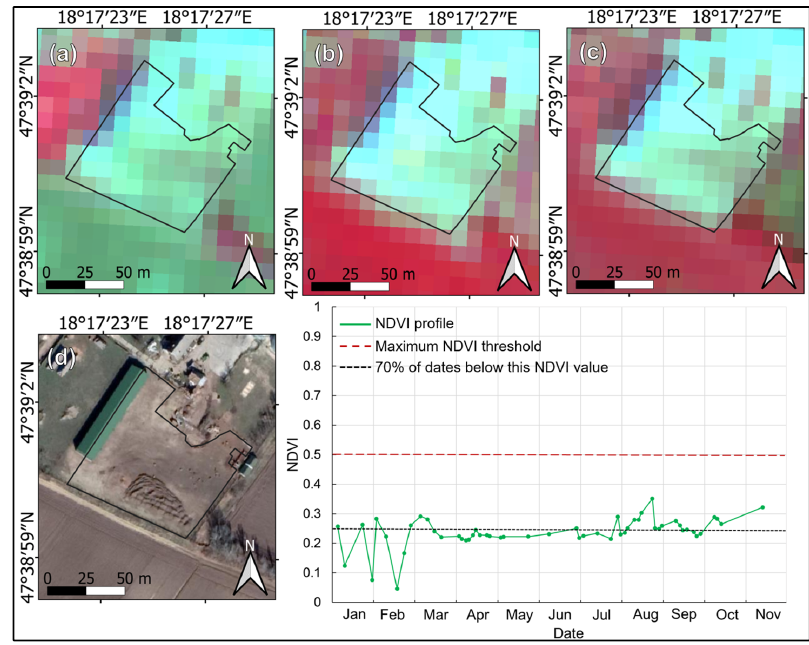
Figure 8. Example of overgrazed area on an NDVI time series and subsets of Sentinel-2 images ac-